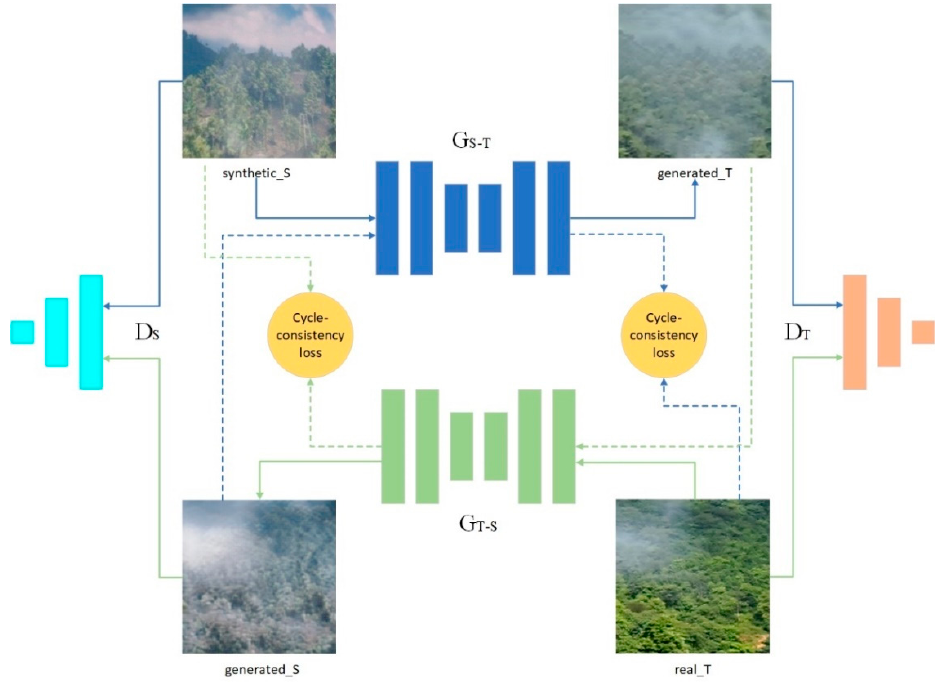
Figure 5. CycleGAN ‐ based pixel ‐ level domain adaptation